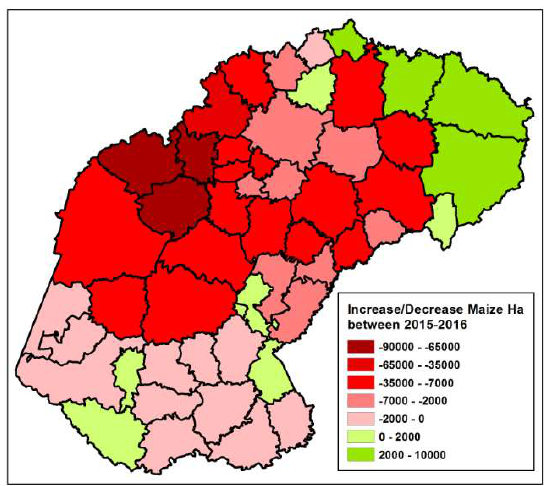
Figure 13. Calculated increase or decrease in area (Ha) of maize cultivated in 2015 and 2016 in Freestate From the maps of maize increase or decrease Ha cultivated per district in the Freestate (Figures.12&13) it is evident that between 2015 and 2016 a massive decrease in maize cultivated over most districts are observed. In 2016 South Africa faced a major drought which severely affected the Freestate province. The drought affected the western regions of the Freestate more than the eastern regions. The high maize producing districts on the north western border (refer to Figures 4&8) showed massive decreases in the area cultivated with maize between 2015 and 2016. The CEC maize estimate dropped from 1 220 000 Ha in 2015 to 700 000 Ha in 2016 (DAFF 2015 & DAFF 2016). Soybean area change maps for the same periods are found in Figures 14&15.